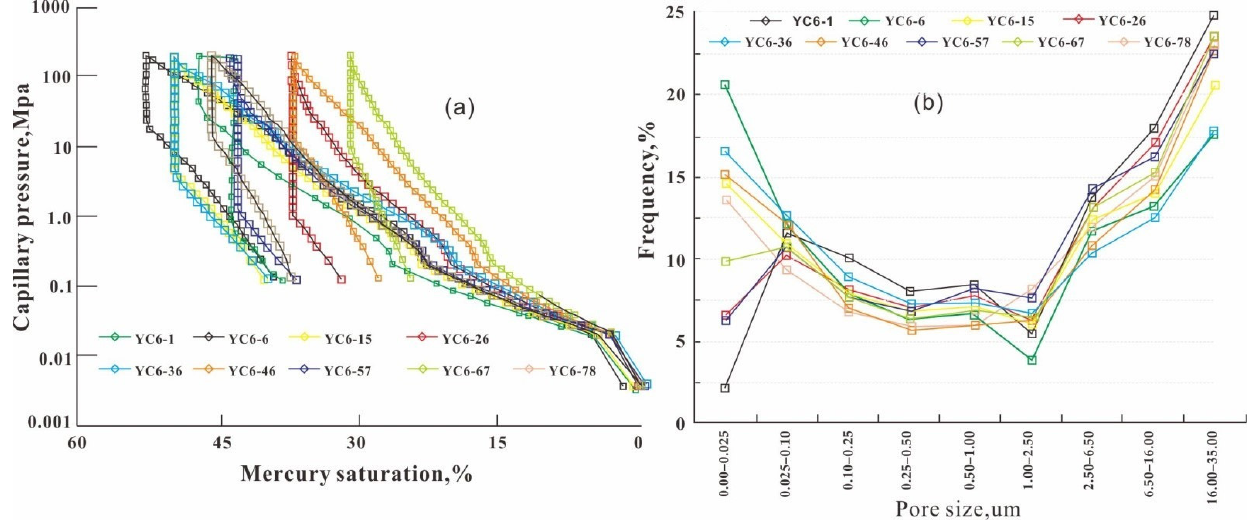
Figure 4. High pressure mercury injection data for shale in Well Yucan-6. ( a ): Capillary pressure curve; ( b ): Pore size distribution.